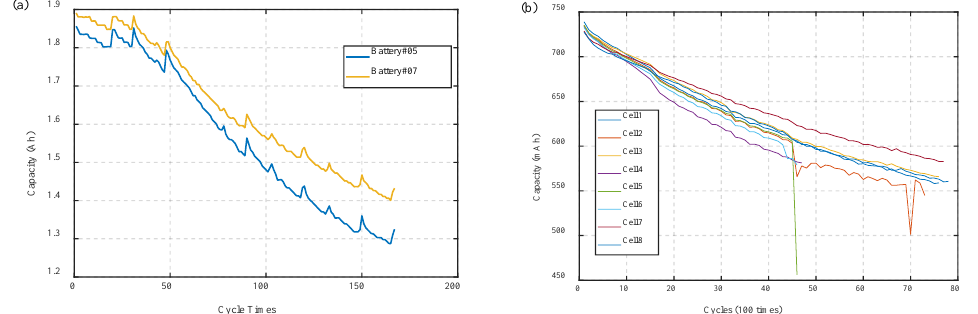
Figure 7. ( a ) The capacity curve of Prognostics Center of Excellence (PCoE) battery data sets #05, #07. ( b ) The capacity curve of Cell1-Cell8 in Oxford Battery Degradation Dataset 1.